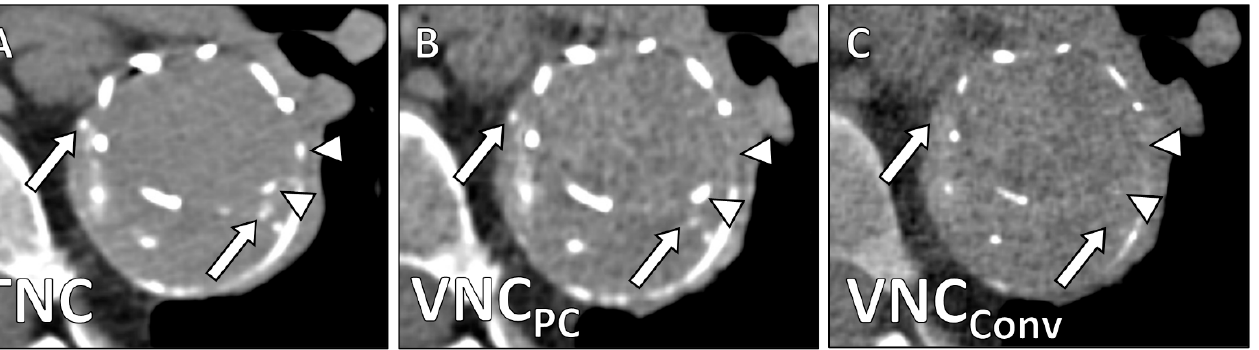
Figure 2. Erroneous removal of stent struts in VNC Conv -reconstructions demonstrated in corresponding axial images in a patient after thoracic EVAR. White arrows demonstrate stent struts (reference: TNC-series A , D ) that despite lower density are well visualized in VNC PC -reconstructions ( B , E ) but are absent in VNC Conv -reconstructions ( C , F ).